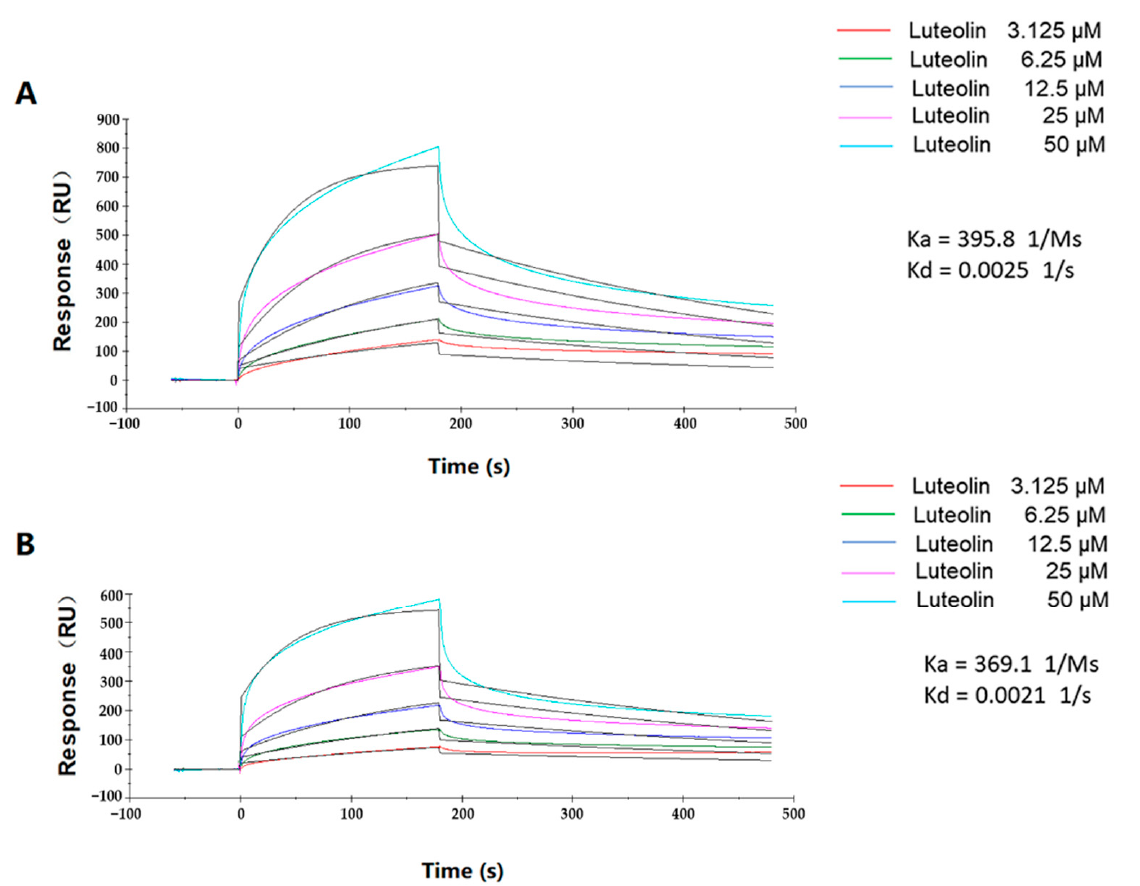
Figure 7. Binding of luteolin and TatD DNases in SPR assays. Luteolin was tested in various concen- trations (3.125–50 µ M). ( A ) Kinetic analysis of luteolin and TatD960, ( B ) kinetic analysis of luteolin and TatD825.